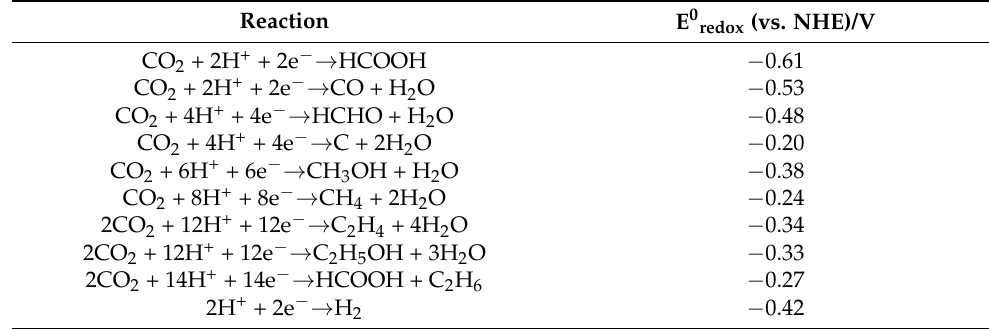
Table 1. Different reduction products obtained from the photocatalytic reduction of CO 2 in an aqueous solution and the corresponding electrode potentials (vs. standard hydrogen electrode, 25 ◦ C, pH =